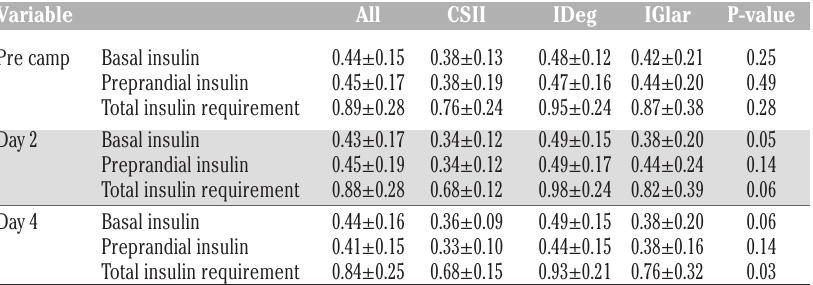
Table 2. Change in insulin pro-Kg requirement before and during the camp.